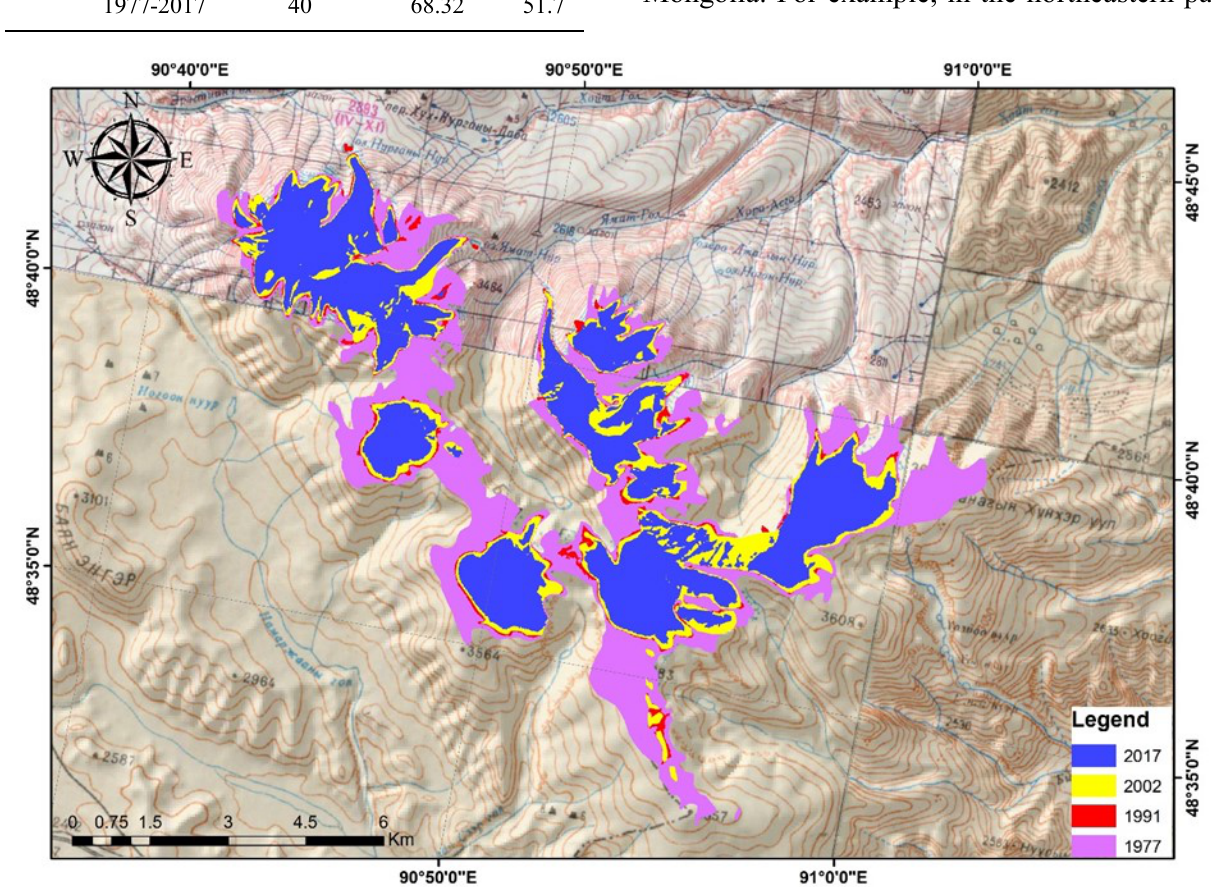
Fig. 5. Changes in extended area of the modern glacier in Mt. Tsambagarav in